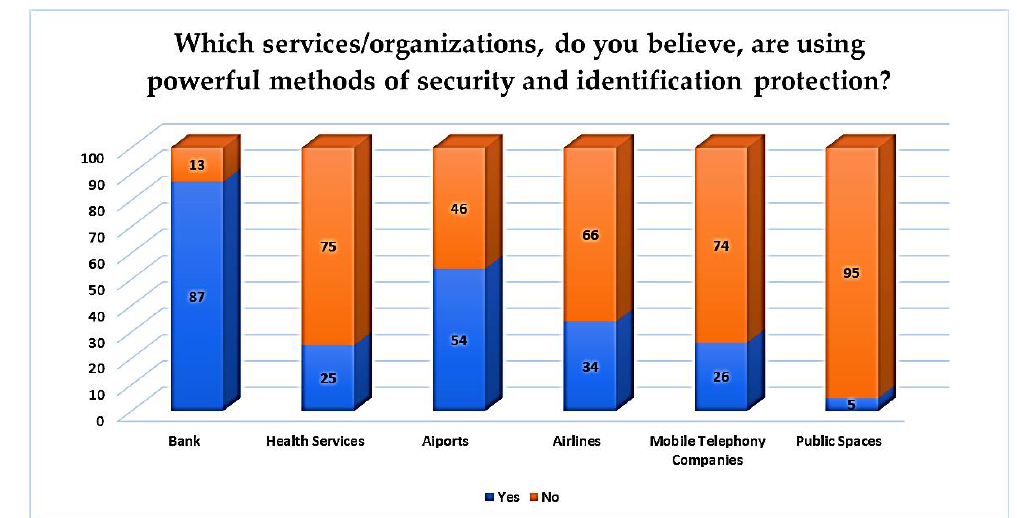
Figure 22. Services with security and identity protection .